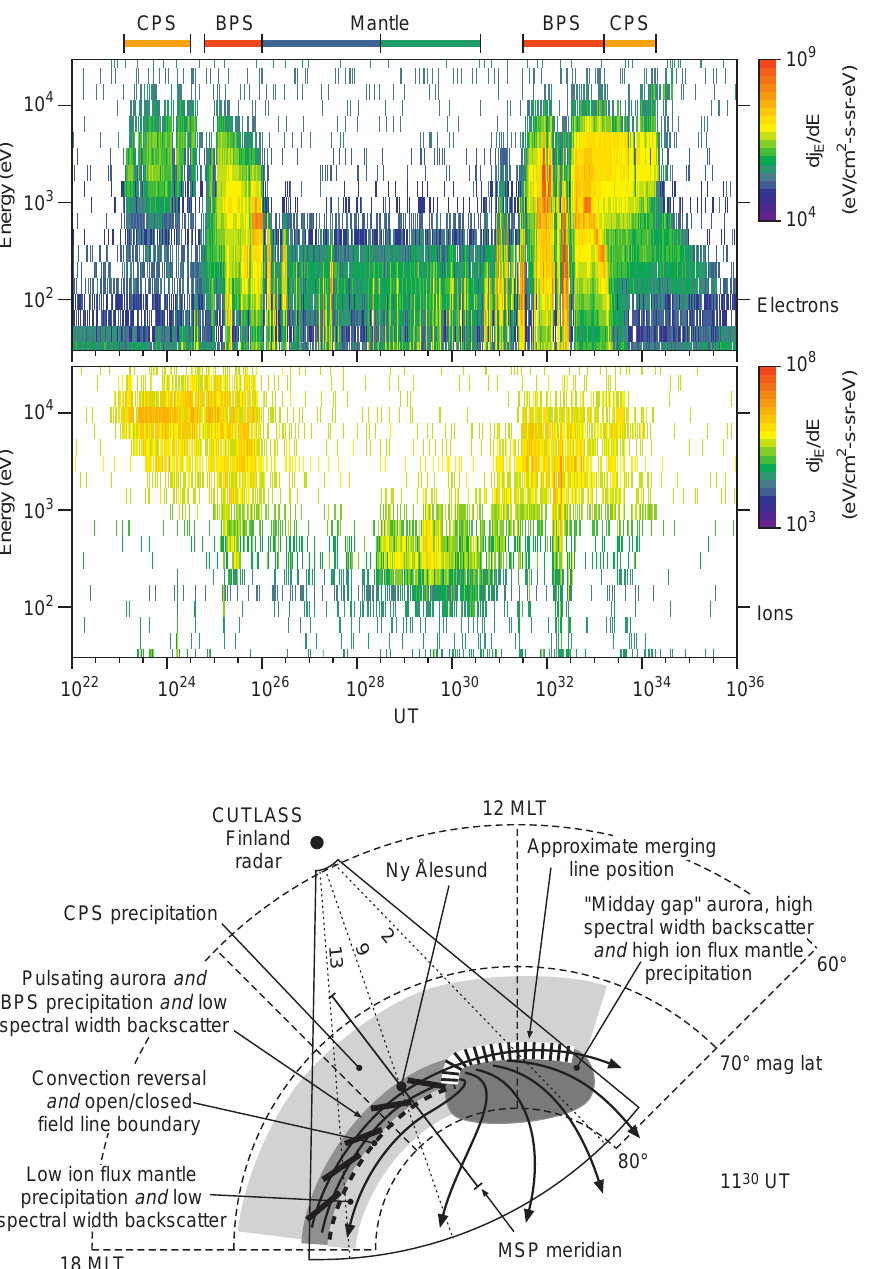
Fig. 5. A schematic representation of the radar and optical observations for the interval of study. The radar field-of-view and MSP meridian are indicated for 1130 UT. The pulsating aurora are ob- served co-located with BPS precipitation, located between the post-noon convection reversal boundary and the equatorward boundary of the